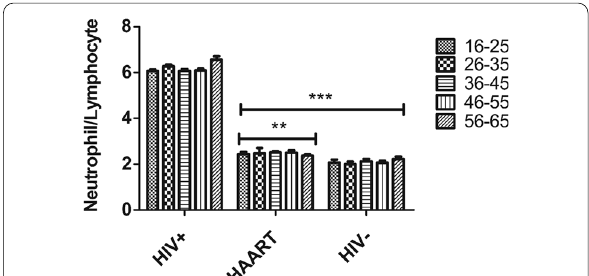
Fig. 1 Neutrophil/lymphocyte ratio of age-matched HIV-positive patients, HIV patients after a year of HAART and HIV-negative subjects. *** p < 0.001 versus HIV-positive; ** p < 0.01 versus HIV-negative. HIV ve HIV-positive group, HAART HIV-positive patients on HAART, + HIV-negative HIV-negative group. The neutrophil/lymphocyte